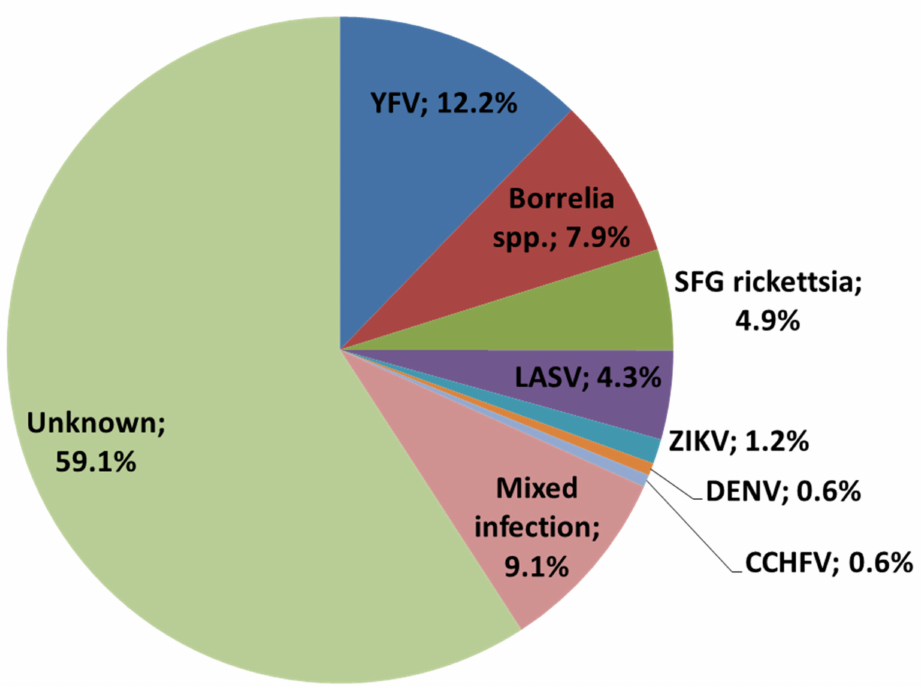
Figure 2. Distribution of zoonotic diseases in the study group, in